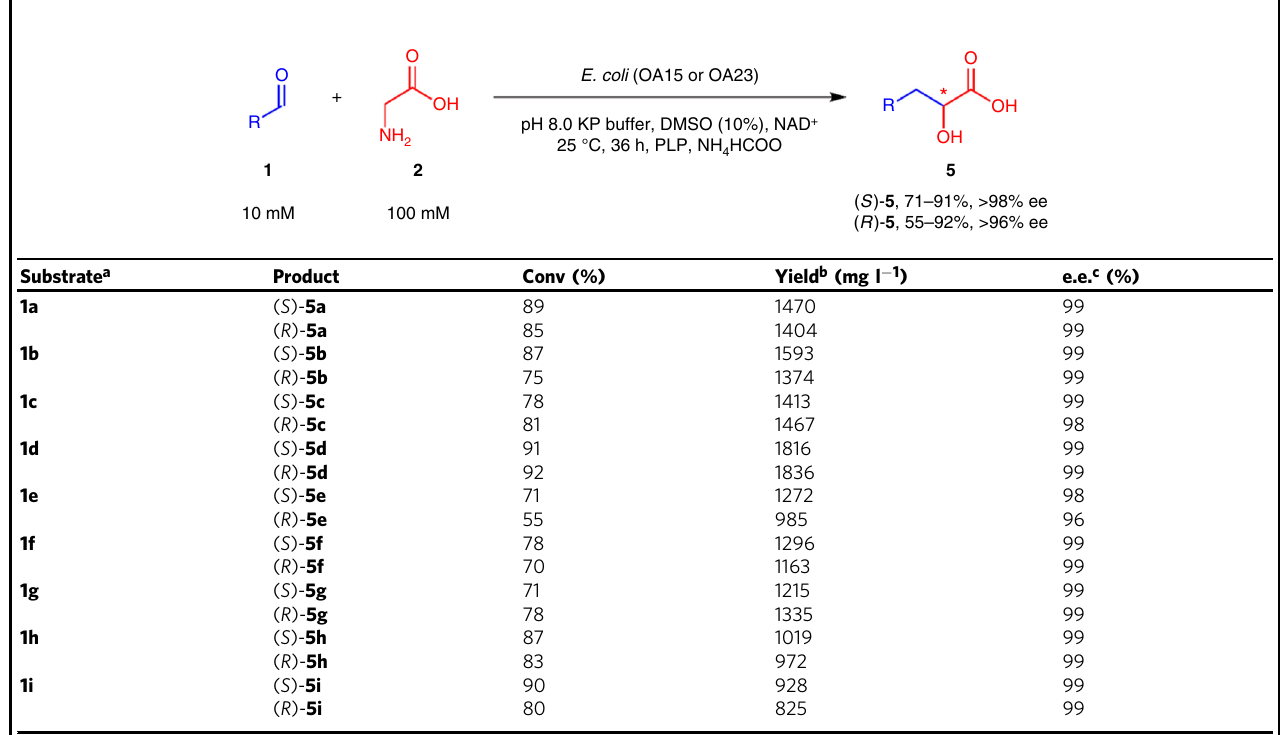
a Reactions were performed in duplicate with resting cells of E. coli (OA15 or OA23) (10g dcw l − 1 ) and 1a – i (10mM) in 2ml KP buffer (50mM, pH 8.0, 100 µ M PLP, 1mM NAD + , and 10% DMSO) at 200rpm and 25°C for 36h b The conversion and yields were obtained after completion of the reactions and determined by HPLC analysis. The values are averages of two experiments c Enantiomeric excess (e.e.) was determined by chiral HPLC analysis (Supplementary Figs 8-15). The values are averages of two experiments